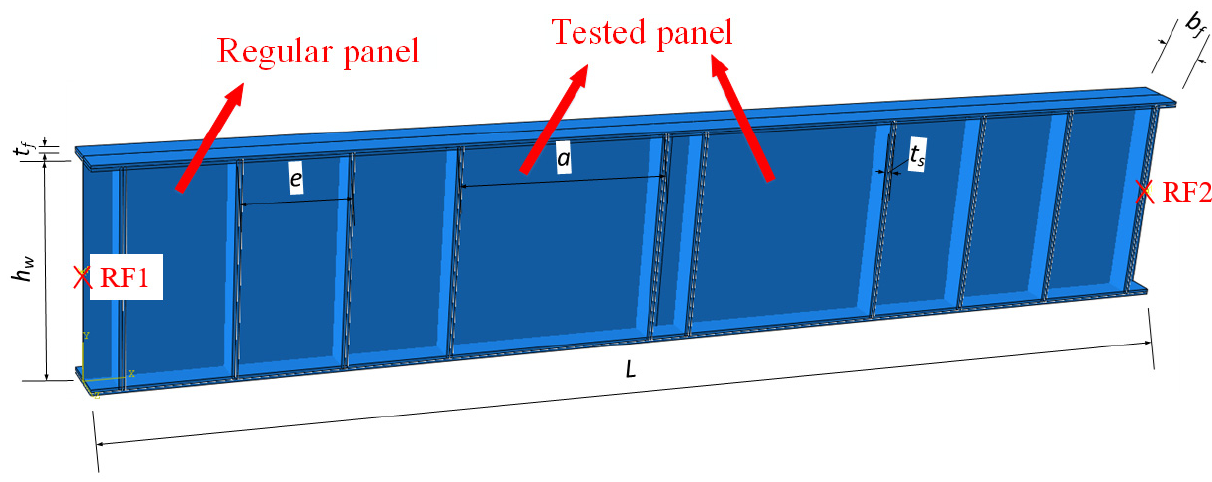
Figure 9. Structure form of plate girder model. Table 2. Geometric dimensions for S600E sorbite SS plate girders: a / h w = 1, h w / t w =